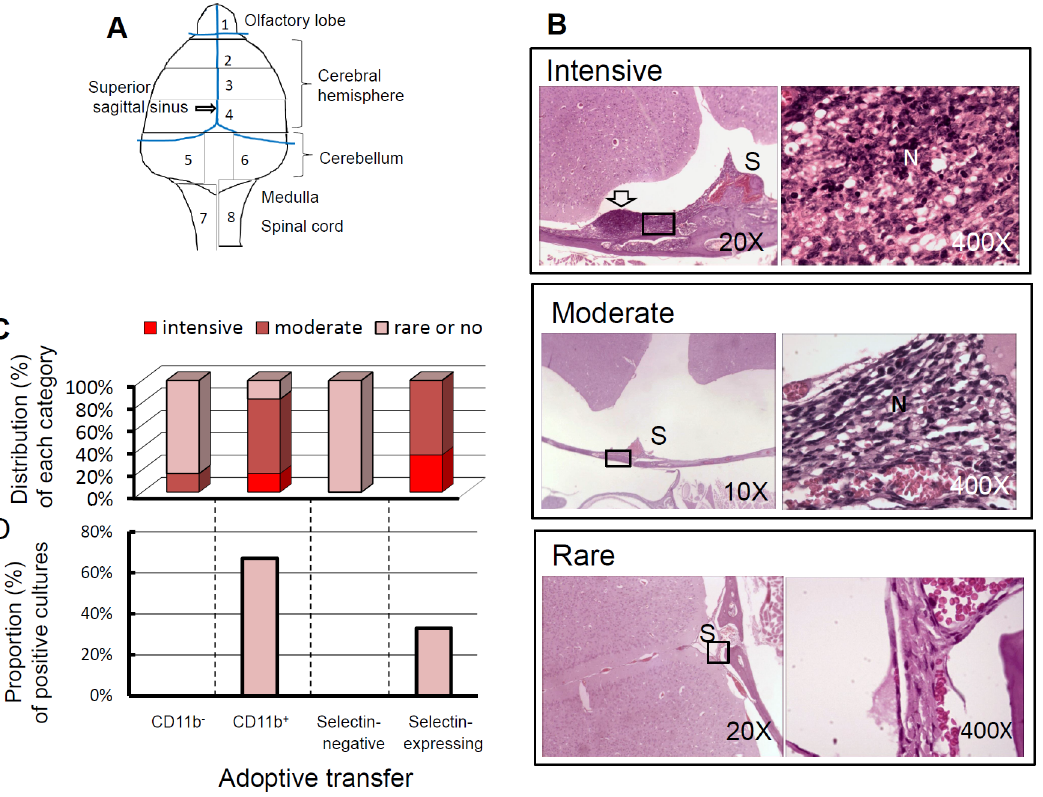
Figure 8. Histological and bacteriological examination of the brains of recipients after adoptive transfer. The mice were sacrificed (n=3, independent duplicate experiments) on day 2 post-transfer. A total of 8 wax blocks were prepared as shown. Histological changes in the meninges were observed only in blocks 2 and 3 (A). Representative images of intensive and moderate meningeal neutrophil infiltration and vascular congestion with rare cell infiltration are shown (10 6 or 20 6 , left column; 400 6 , right column, magnified from the black square). The position of the superior sagittal sinus (S) and the presence of neutrophils (N) or abscesses (arrow) are indicated (B). The distribution (%) of each histological category (intensive, moderate and rare neutrophil infiltration) is shown (C). Simultaneously, CSF samples were collected and seeded into culture bottles. The proportion (100%) of positive B. pseudomallei cultures obtained from the tested mice is shown. The lower limit of CSF detection was 200 CFU/ml (D).